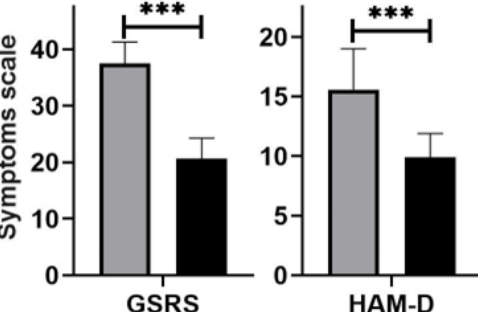
Figure 6. The core of the gastrointestinal symptoms rating scale (GSRS) and Hamilton Depression Rating Scale (HAM-D) score in depressive patients with small intestinal bacterial overgrowth before (grey) and after (black) rifaximin treatment. Differences were examined using the Wilcoxon signed rank test; n = 40; *** p < 0.001.